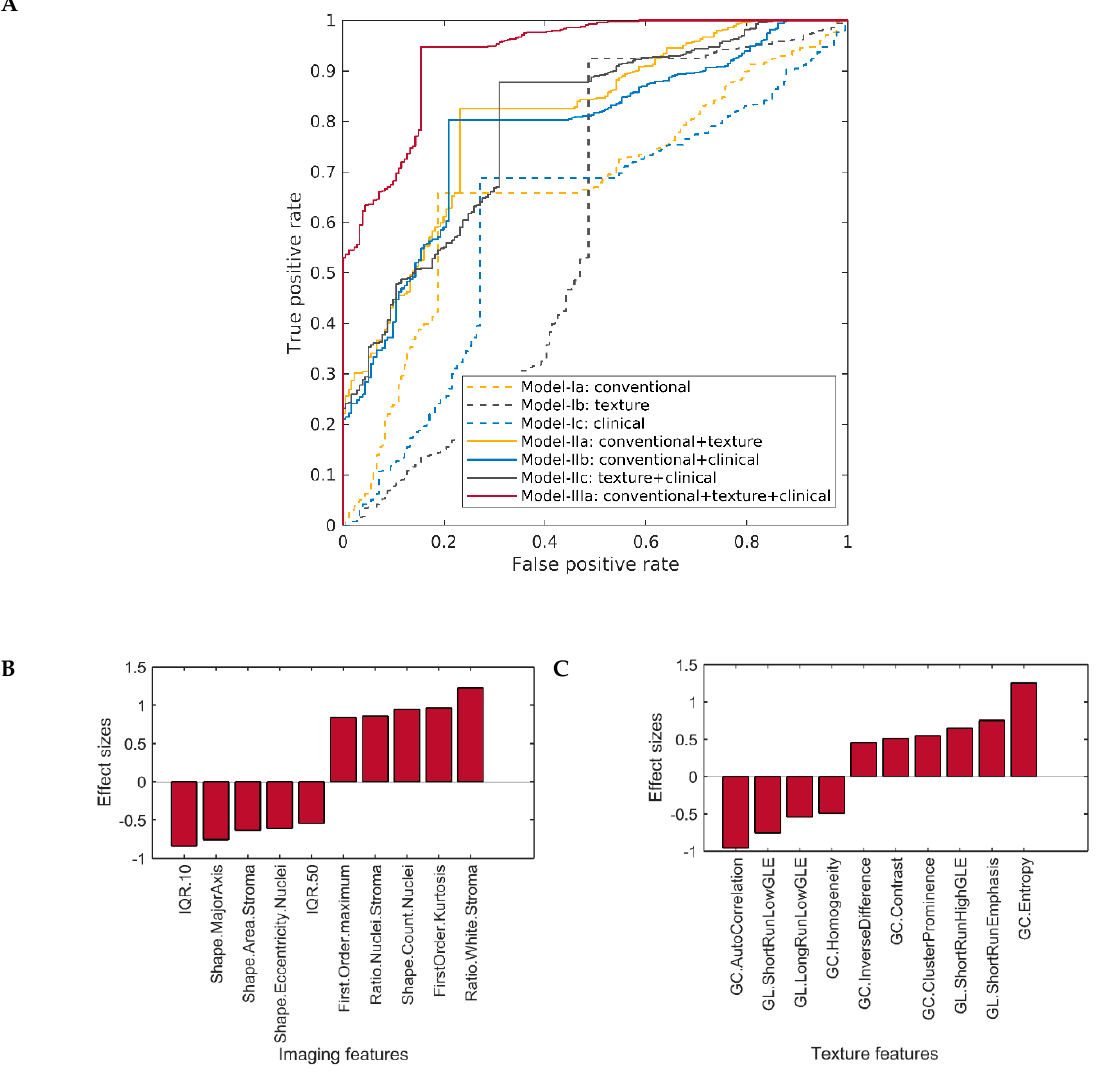
Figure 2. ( A ) Receiver operating characteristics (ROC) curves of one-layer and two-layer models in comparison with the three-layer model based on the predictions of the proposed model. ( B ) Discriminatory capability of conventional imaging features selected by model-1a, and ( C ) discriminatory capability of texture features selected by model-Ib. The discriminatory capability of the features is shown in terms of effect size; the higher the value of effect size, the more discriminative the feature is. The positive effect size indicates the value of the feature to be higher in high-grade gliomas (HGGs), and negative effect size shows the value of the feature to be lower in lower-grade gliomas (HGGs). GL = gray-level run-length matrix, GC = gray-level co-occurrence matrix, GLE = gray-level emphasis, IQR = inter-quantile range. Table 2. Quantitative results for grade prediction in gliomas. The experiments were performed separately for one-layered models, including model-Ia (imaging features), model-Ib (texture features), and model-Ic (clinical features); for two-layered models, including model-IIa (imaging+texture features), model-IIb (imaging+clinical features), and model-IIc (texture+clinical features); and for three-layered models, including model-IIIa (imaging+texture+clinical features). AUC=area-under- the-curve.